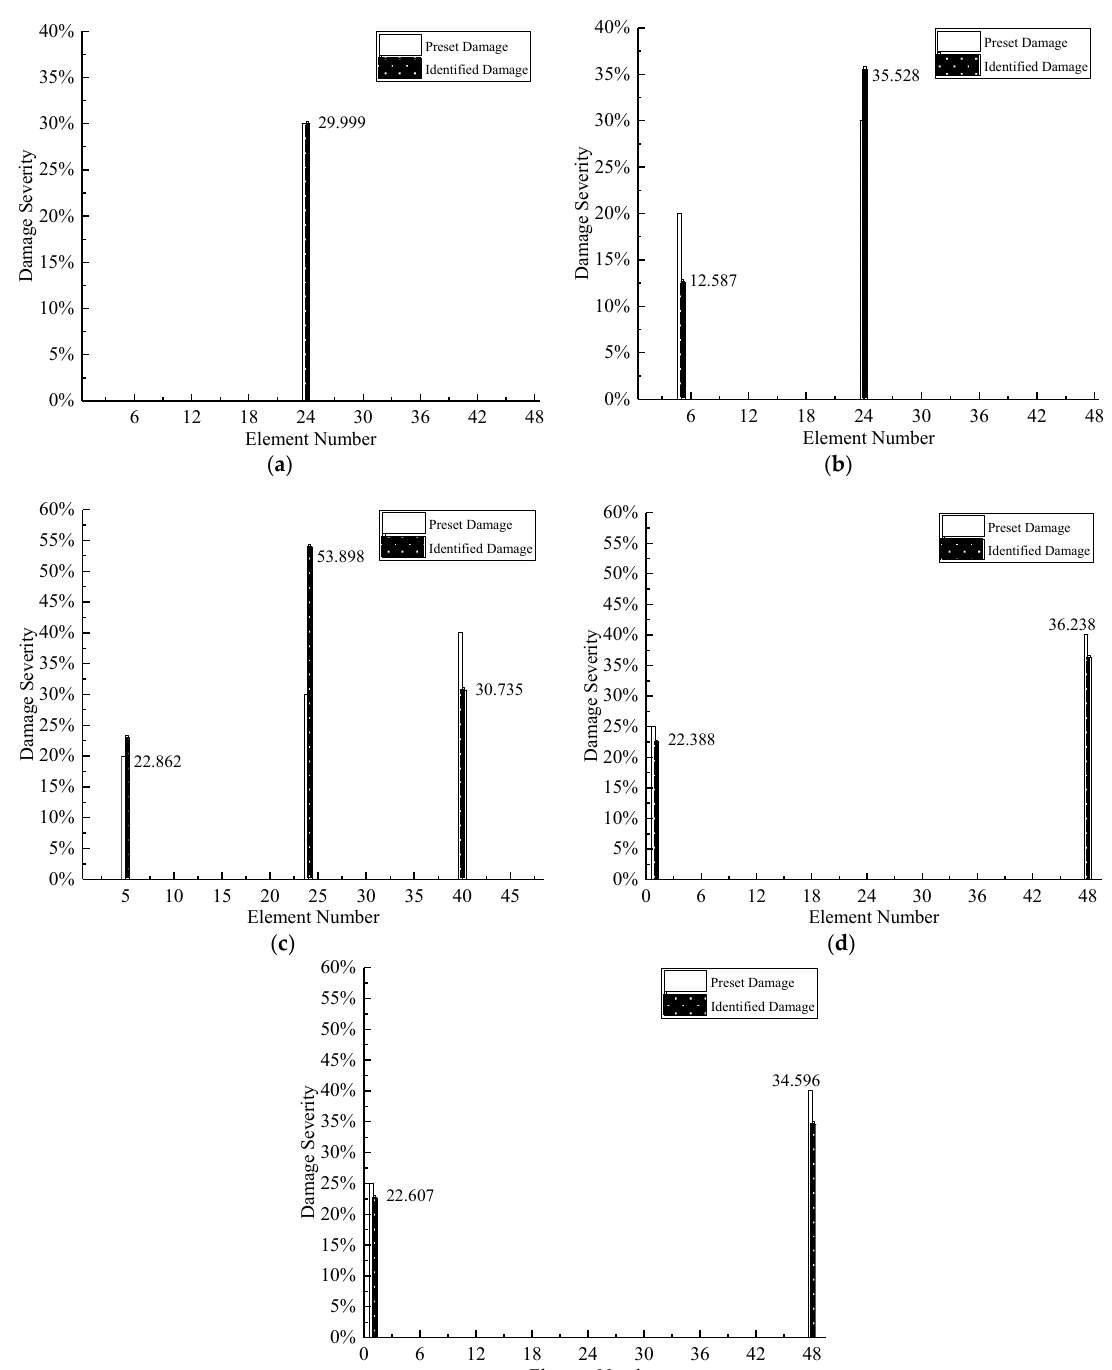
Figure 8. Damage Detection Results of Structural Elements: ( a ) Case 1; ( b ) Case 2; ( c ) Case 3; ( d ) Case 4 and ( e ) Case 5.